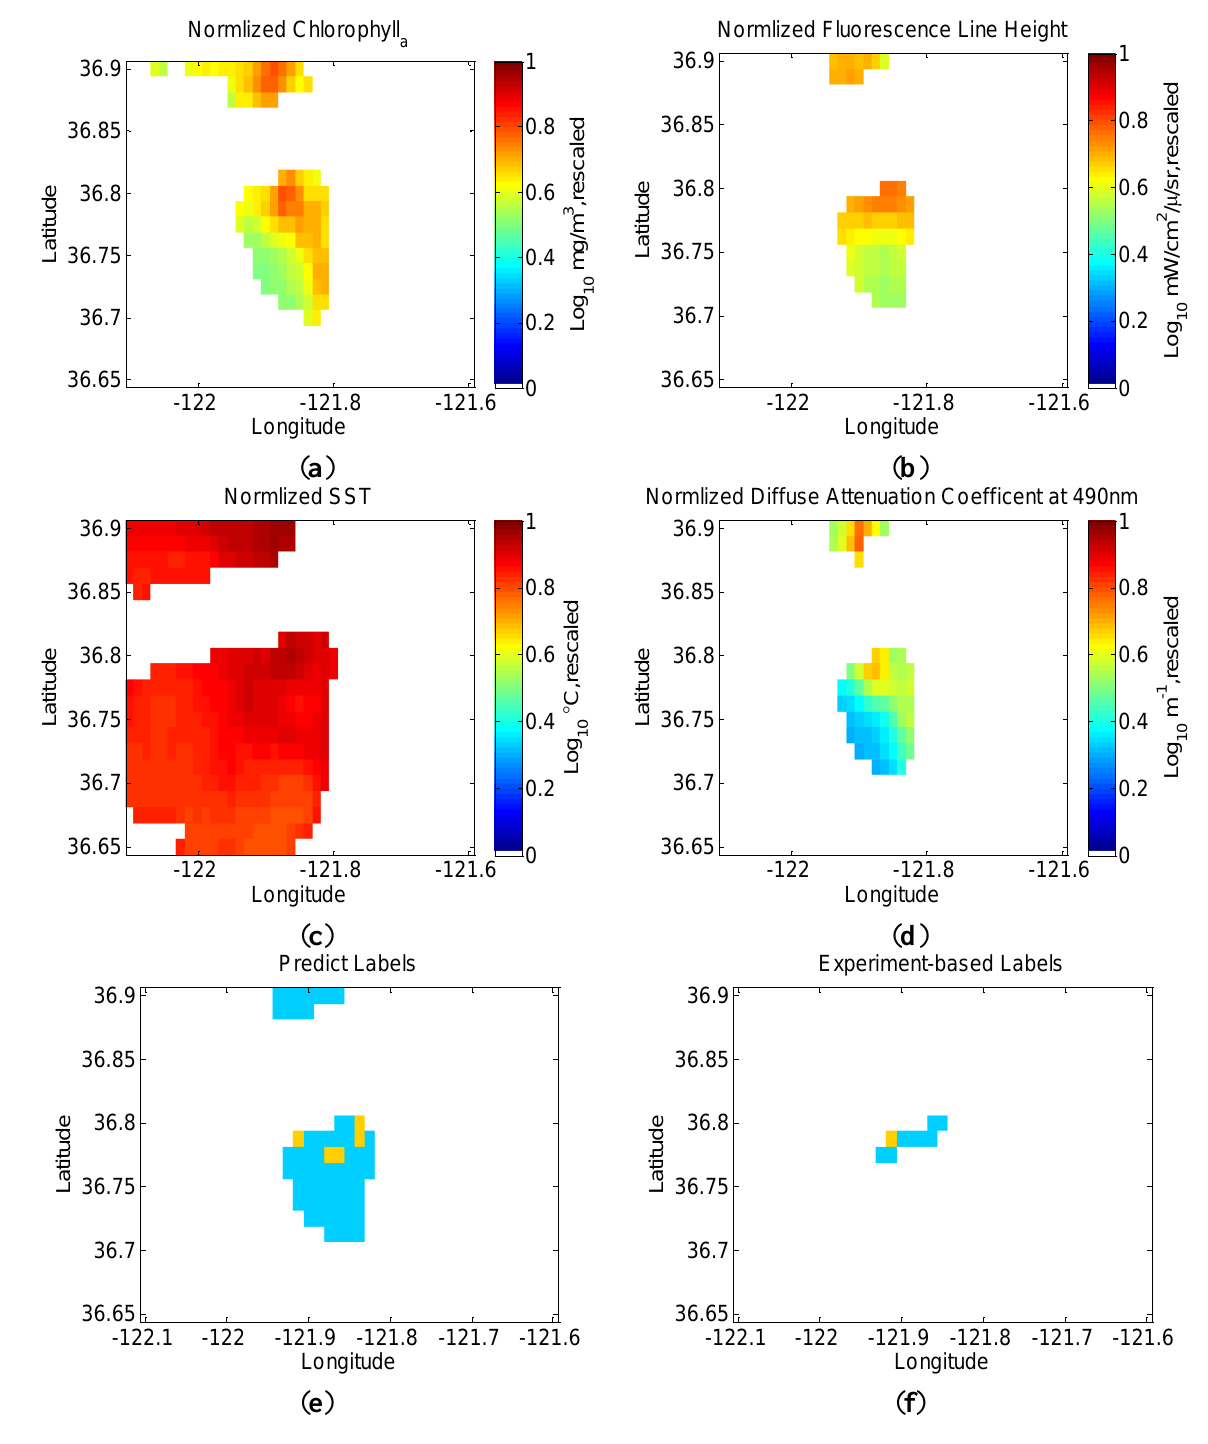
Figure 10. Field experiment evaluation results for 19 September 2014. ( a – d ) represent MODIS-measured chlA, flh, sst and k490. ( e – f ) show labels predicted from the RF model (left) and in situ experimental data (right), respectively. Bloom pixels are shown in yellow, and non-bloom pixels in blue. White areas represent unknown pixels. Because the labels are generated only for the subset of known MODIS imagery, the labels contain a smaller set of pixels than the MODIS images alone. The experiment-based labels are derived by in situ data so that they only cover a small